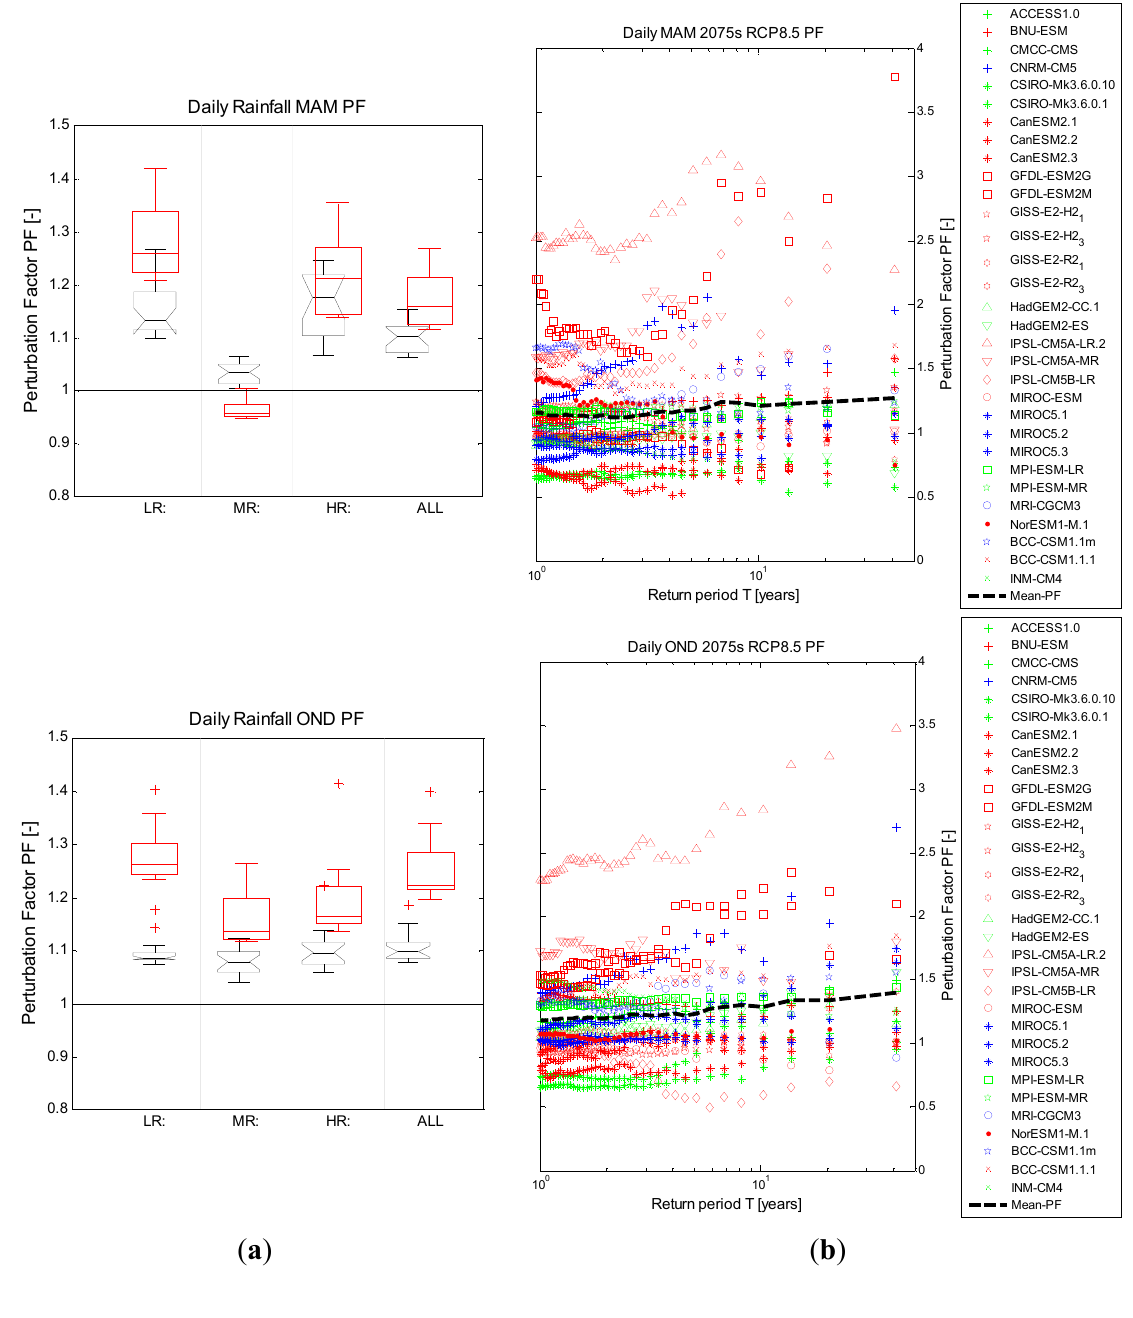
Figure 14. ( a ) Perturbation factors for daily precipitation simulated by GCMs in different seasons for the 2040s (notched) and 2075s, for RCP8.5; ( b ) Perturbation factors vs. return period for daily precipitation simulated by the GCMs in the 2075s for RCP8.5 in the different seasons, Red = LR GCMs, Blue = HR GCMs and Green = MR